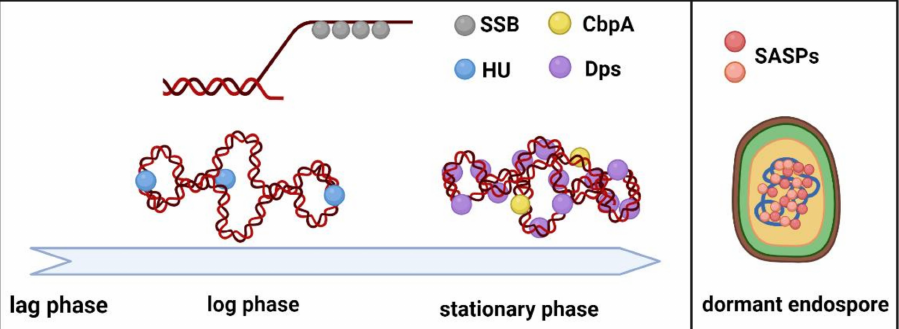
Figure 1. DNA-binding proteins that protect DNA through the bacterial growth cycle. Among spore-forming bacteria SASPs protect genomes in dormant